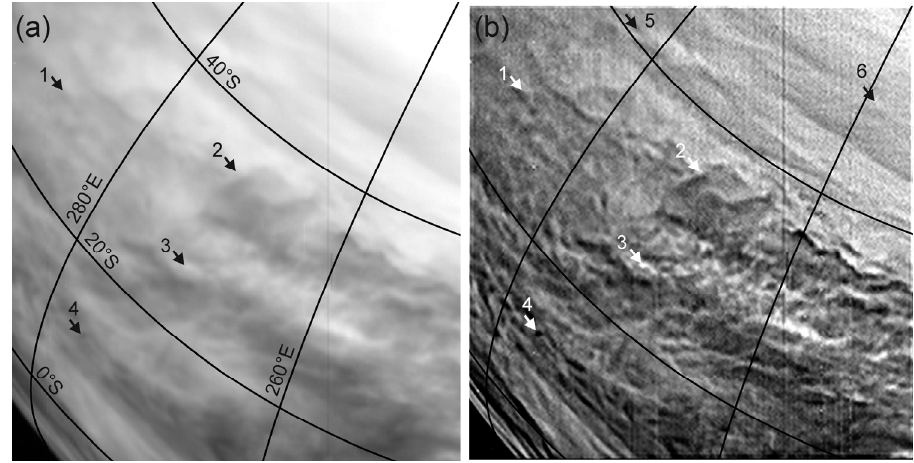
Figure 4. Example of applying a 2D-wavelet filter to a VIRTIS-M image (data cube 569_13). Arrows indicate examples of identified cloud details used in the wind velocity retrieval. ( a ): original image, ( b ): same image after filter application.